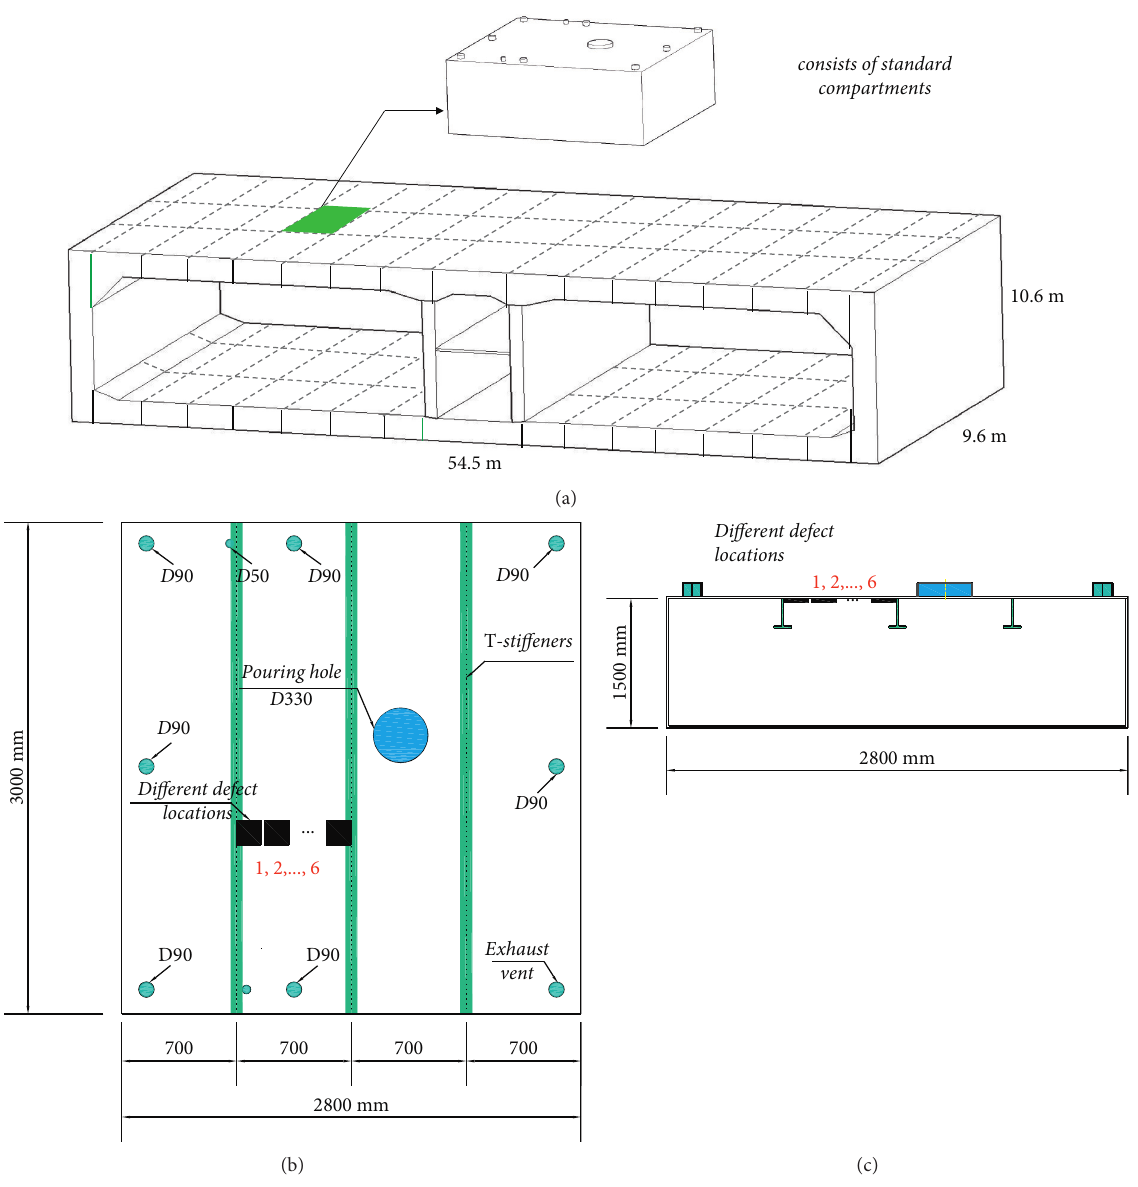
Figure 2: The structure of experiment model; (a) the full-size SSIT model; (b) the top view of the compartment; (c) the front view of compartment.